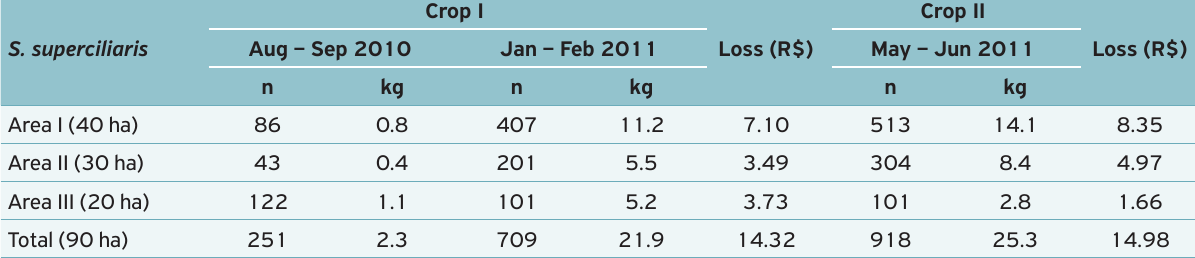
S. superciliaris